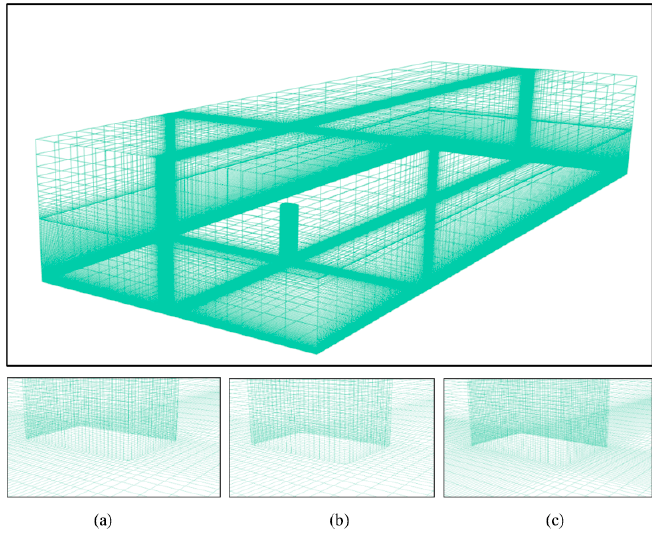
Figure 5. Mesh grid types: ( a ) coarse, ( b ) medium, ( c ) fine. Table 2. Mesh resolutions and refinements.